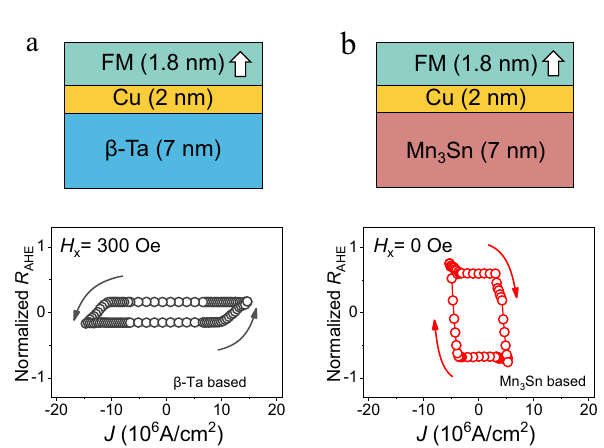
Fig. 3 | External magnetic fi eld tuning polarity of current induced magnetiza- tionswitching.a Currentinducedmagnetizationswitchingwithclockwisepolarity in the absence of an external magnetic fi eld for the Mn 3 Sn (7)/Cu (1)/FM (1.8) device. b The switching curve under different external magnetic fi elds from negative to positive. c The evolution of the switching polarity and switching ratio